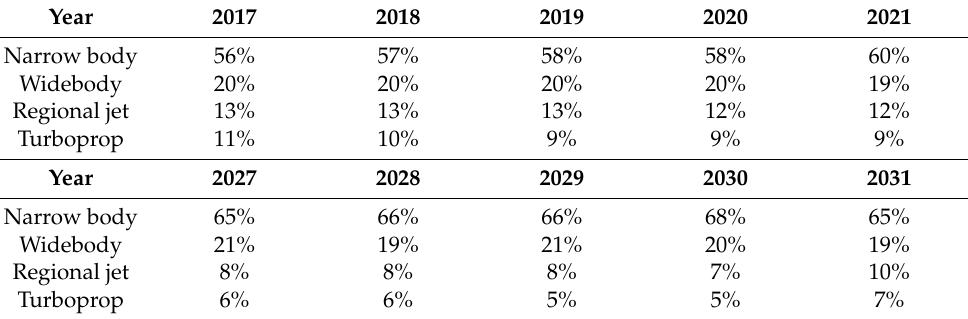
Table 1. Market share by aircraft category